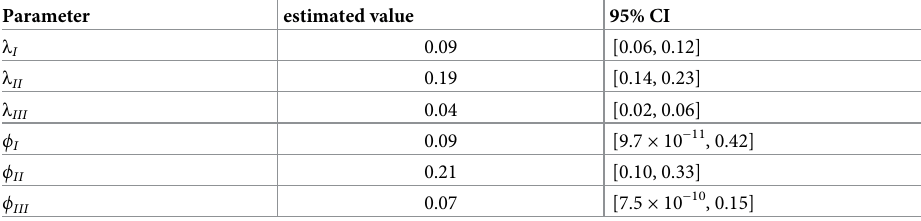
Table 1. The parameter estimates for lymphatic spread of tongue cancer.